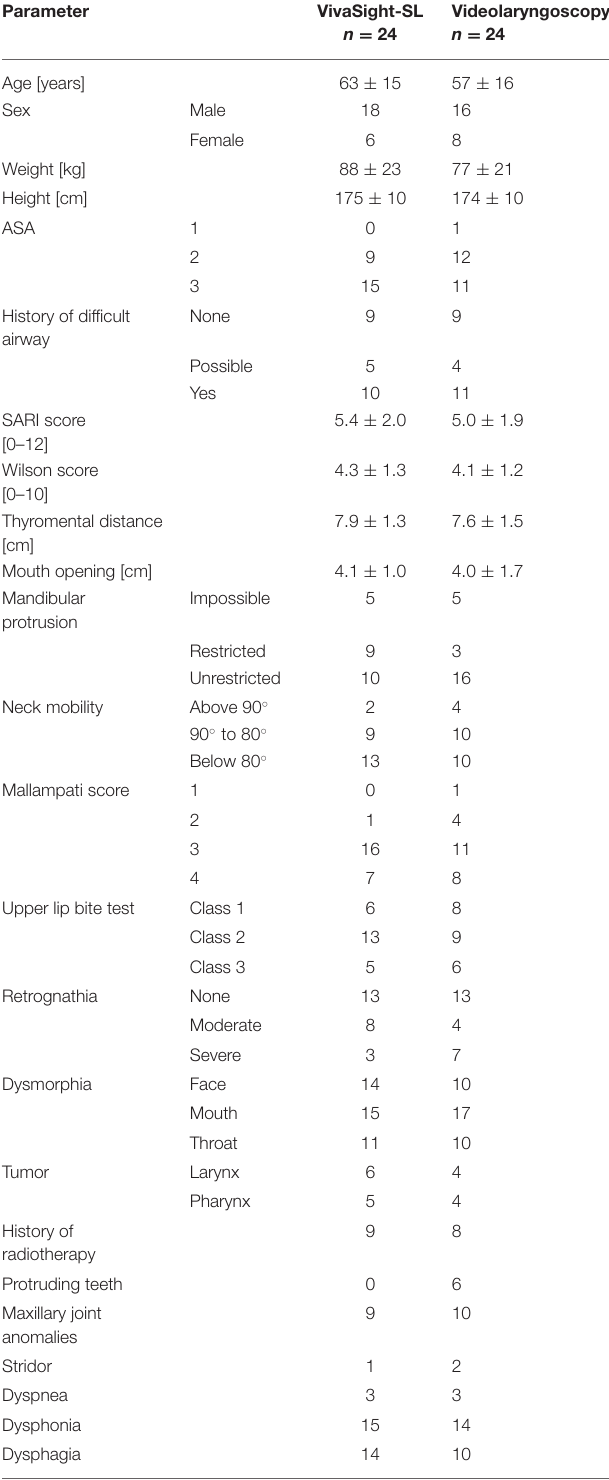
TABLE 1 | The patient characteristics and airway